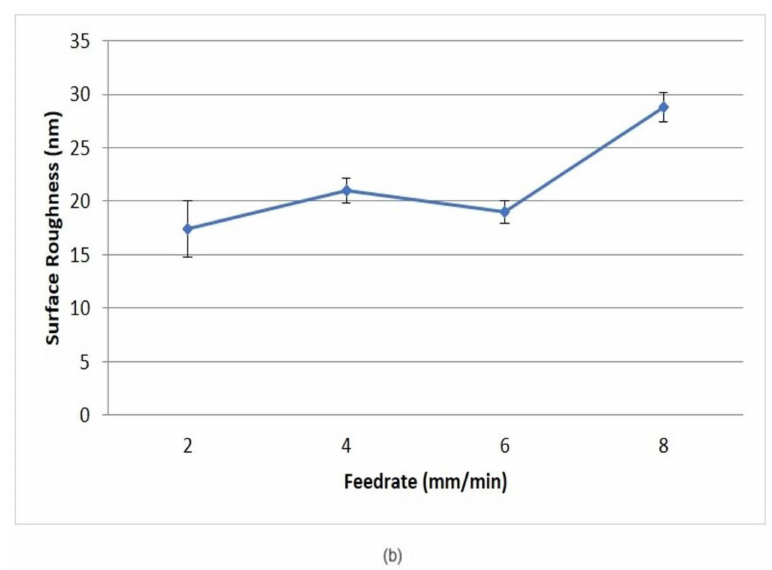
Figure 6. The graph of ( a ) CPR ( Characteristic Peak Ratio ) ’ vs. feed-rate and ( b ) surface roughness vs. feed-rate.